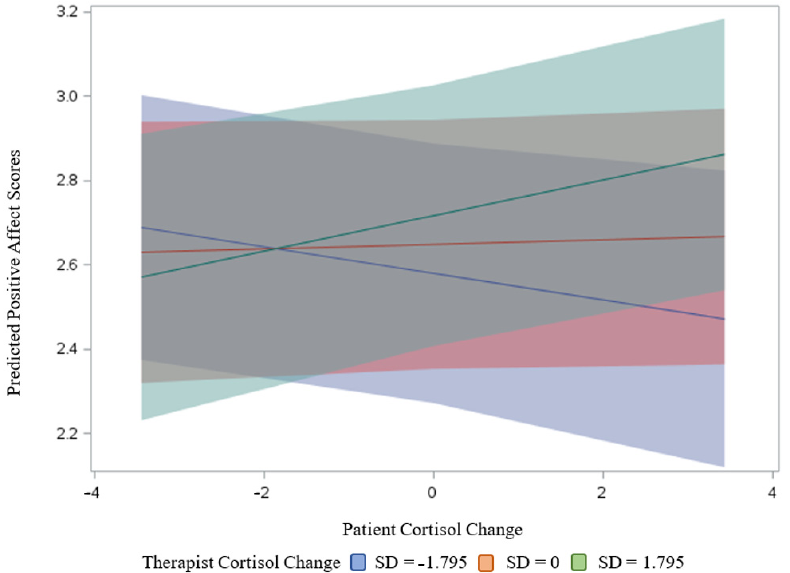
Figure 3. Interaction of patient and therapist cortisol change predicting positive affect. Note. The relationship between patients’ cortisol change and PA was positive and significant when their ther- apists showed greater increases in cortisol (represented in green), but not significant when their therapists showed smaller increases (or greater decreases) in cortisol (represented in